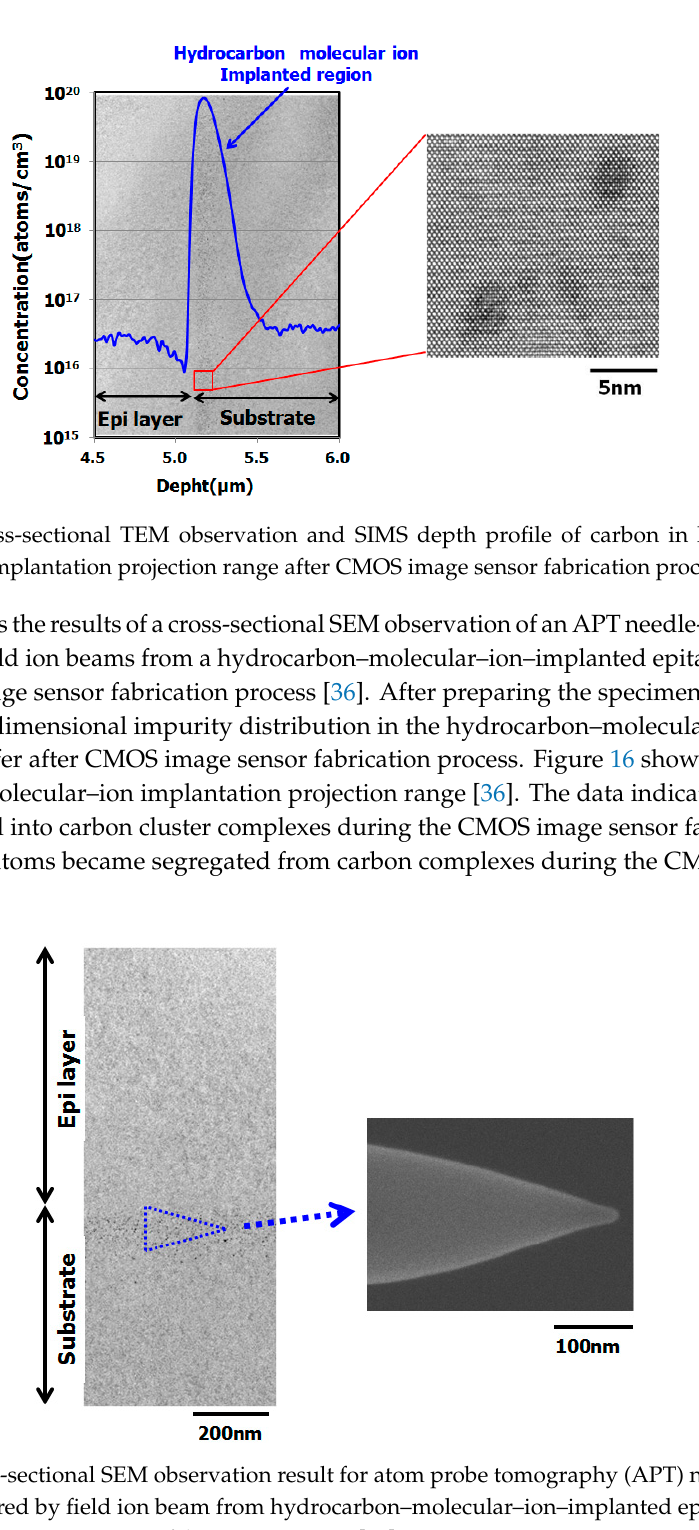
wafers after CMOS image sensor fabrication process [36].